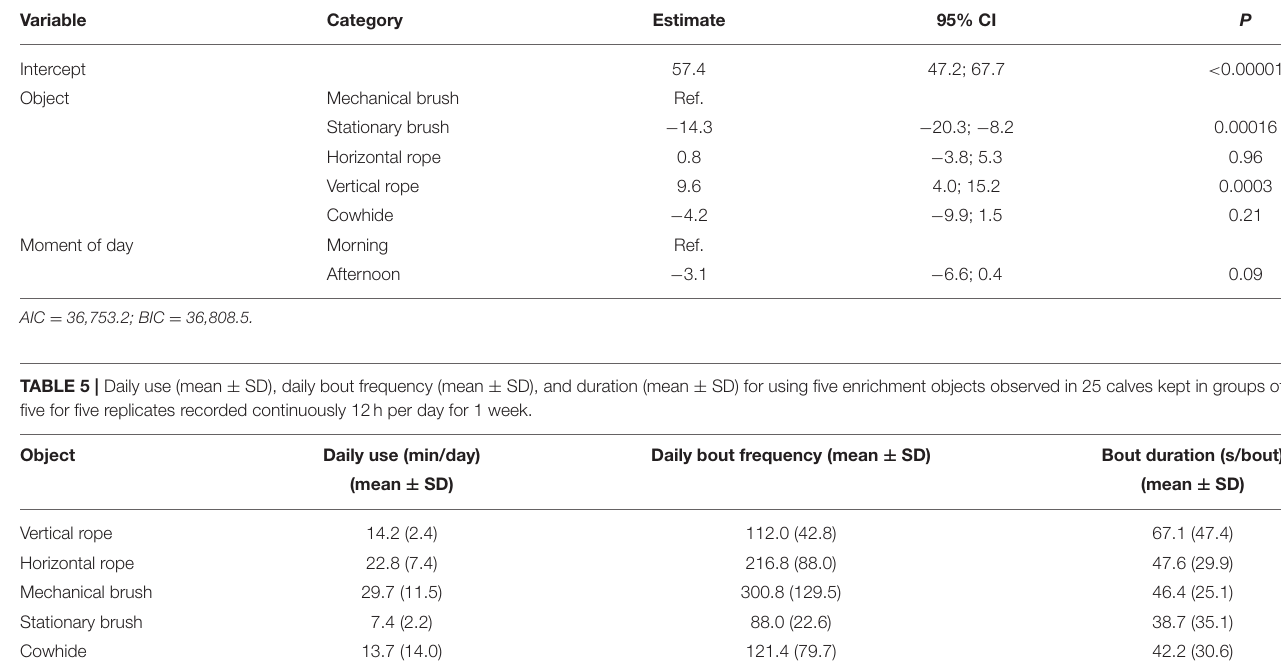
TABLE 4 | Final conditional mixed generalized linear model for factors associated with the duration of the bout use ( n = 4,195s bouts).